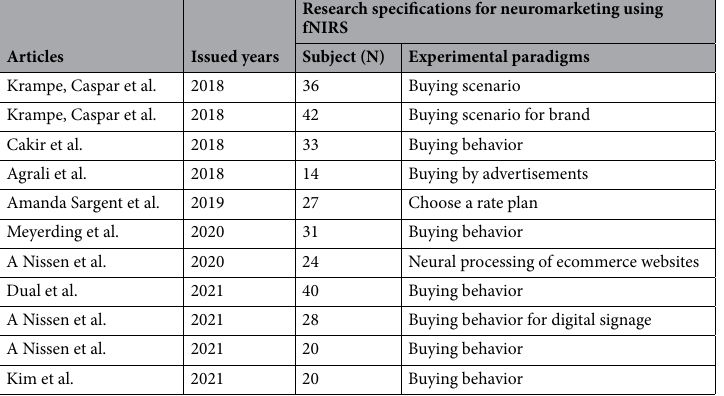
Table 1. Comparison of neuromarketing research on consumer purchasing behavior published over the past four years using